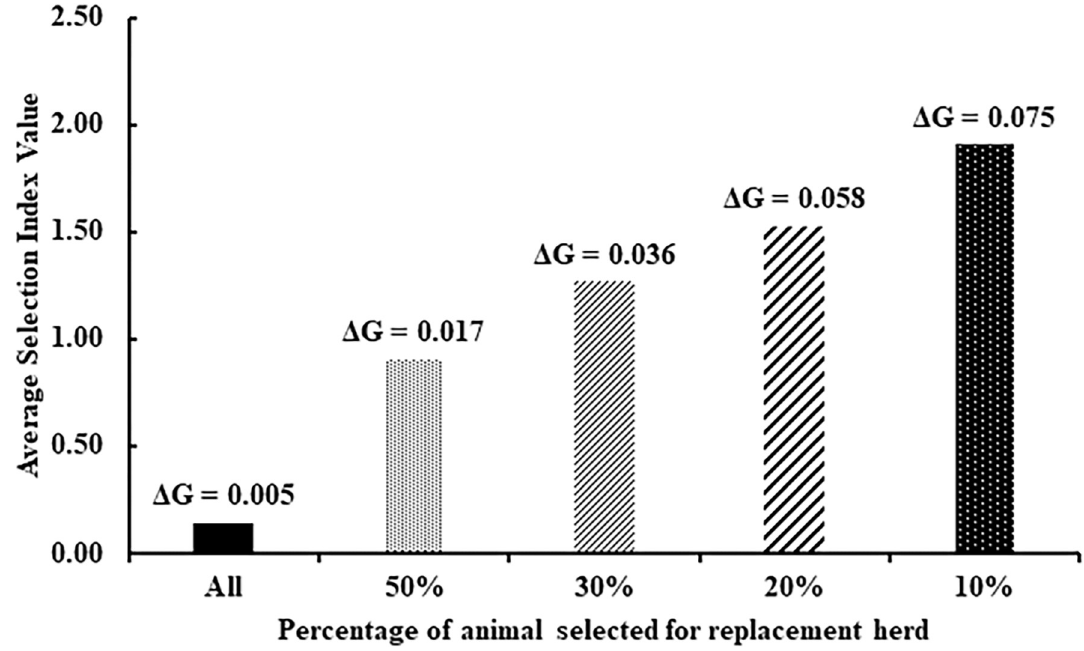
Fig 2. The selection index value (monthly egg number and heat tolerance) and genetic progress from all datasets and the top 50%, 30%, 20%, and 10% of the dataset in Pradu Hang dum chickens.